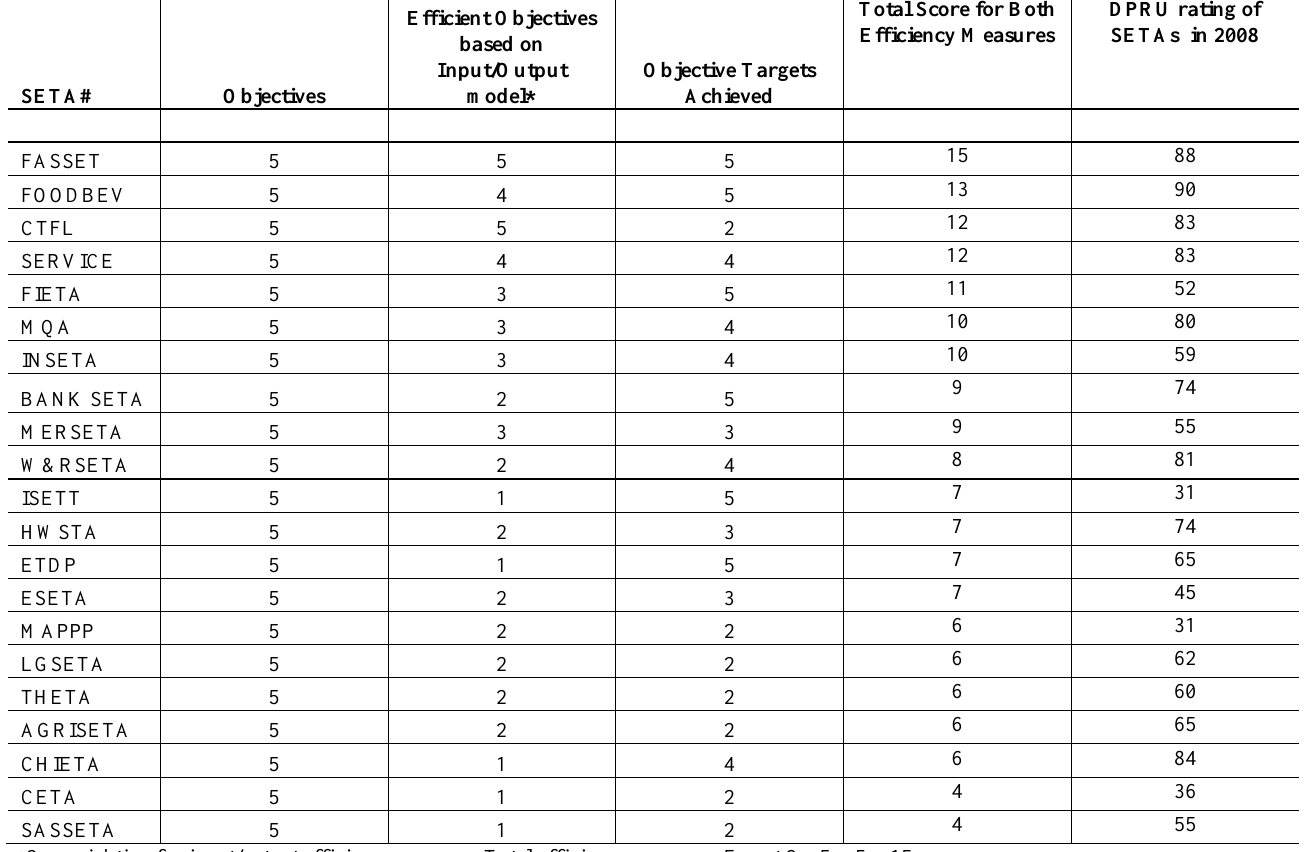
Table 1: Analysis of Efficiency of each SETA based on the Input/Output Model, and the Objective Targets Achieved.